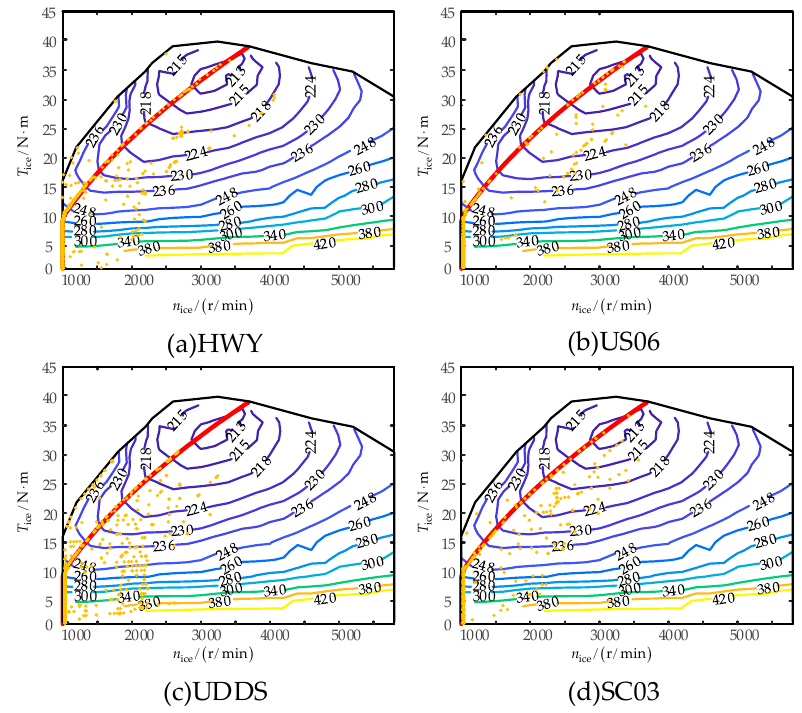
Figure 17. ICE operating points of EREVs under different driving cycles.